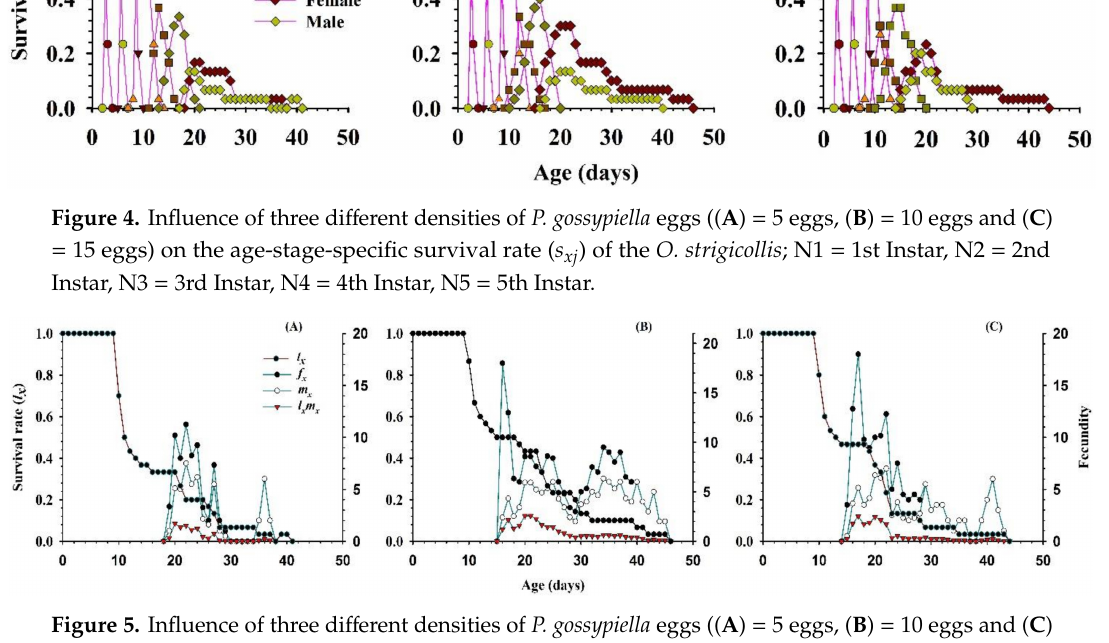
Figure 5. Influence of three di ff erent densities of P. gossypiella eggs (( A ) = 5 eggs, ( B ) = 10 eggs and ( C ) = 15 eggs) on the age-specific survival rate ( l x ), female age-specific fecundity ( f x ), age-specific fecundity ( m x ), and age-specific maternity ( l x m x ) of the O. strigicollis